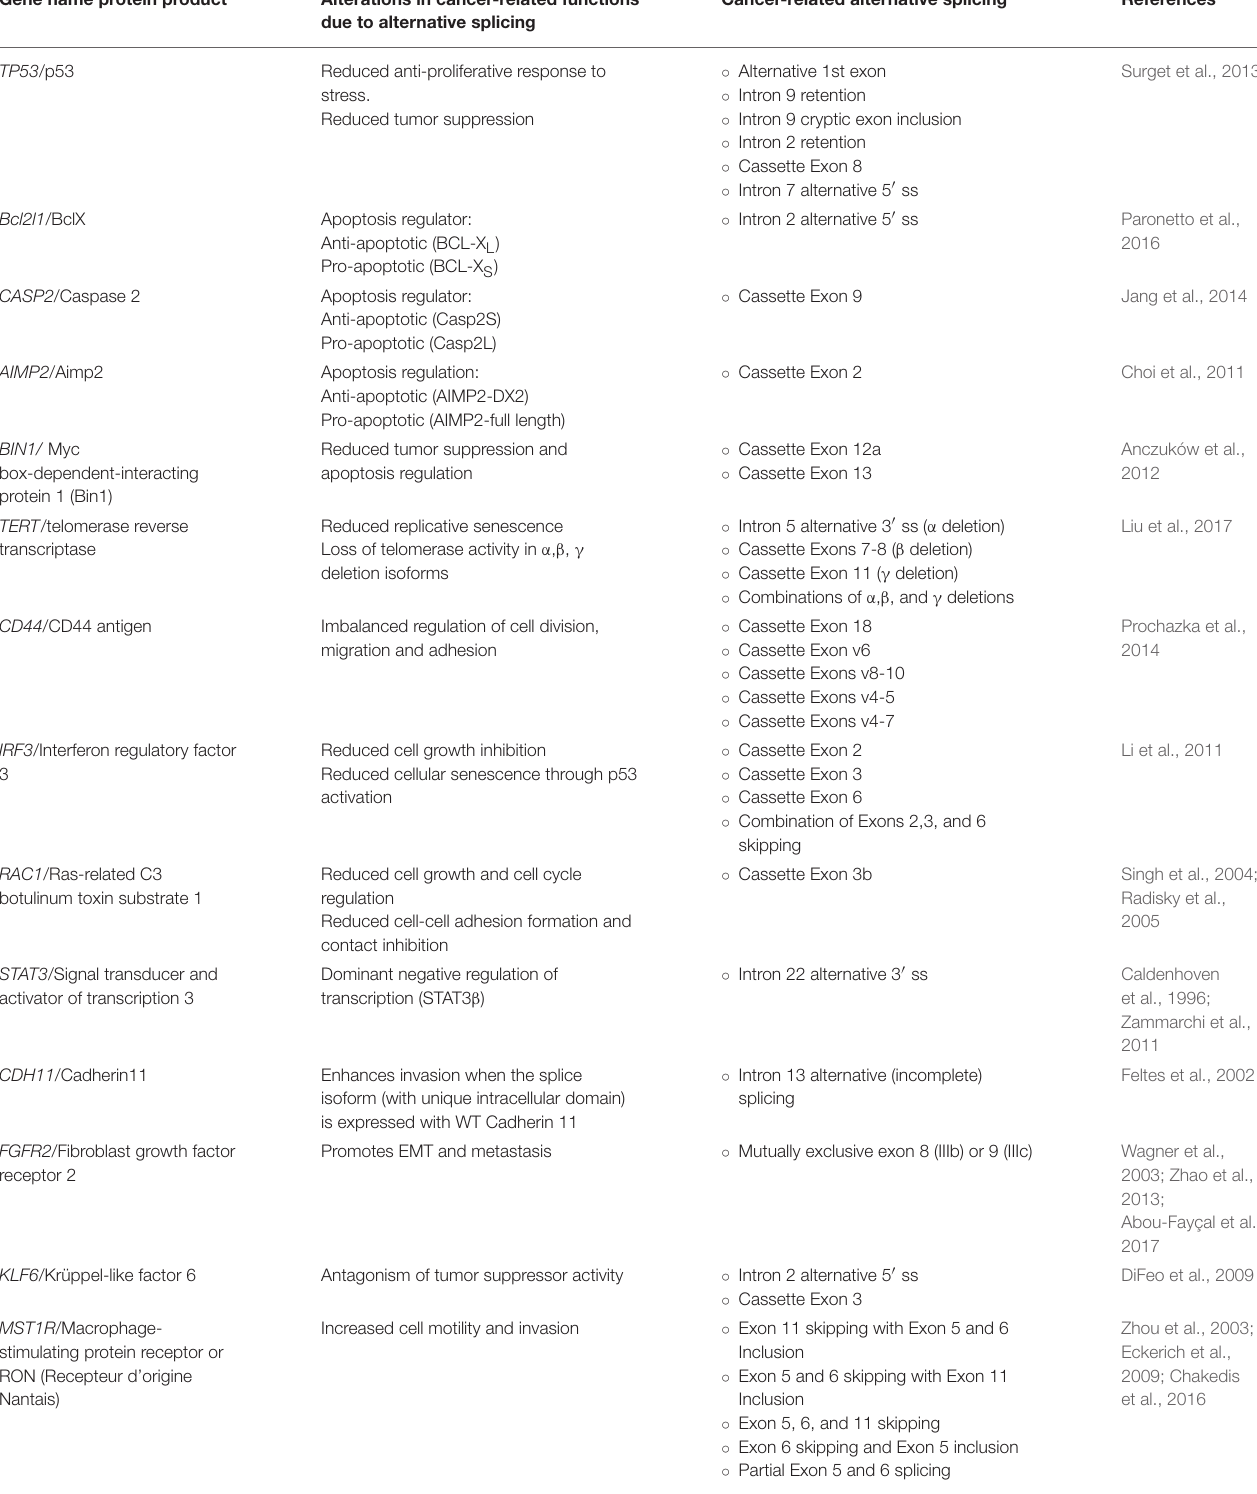
TABLE 1 | Selected examples of genes with cancer-related alternatively spliced